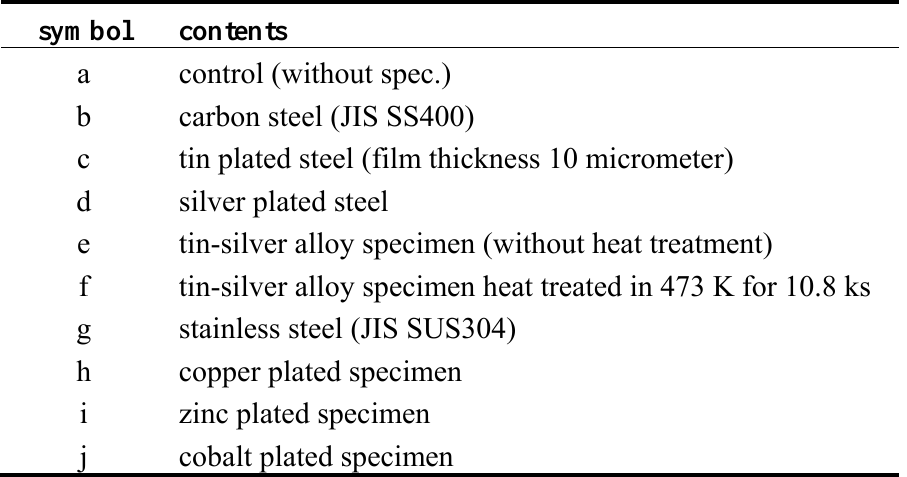
Table 2. Specimens used in this